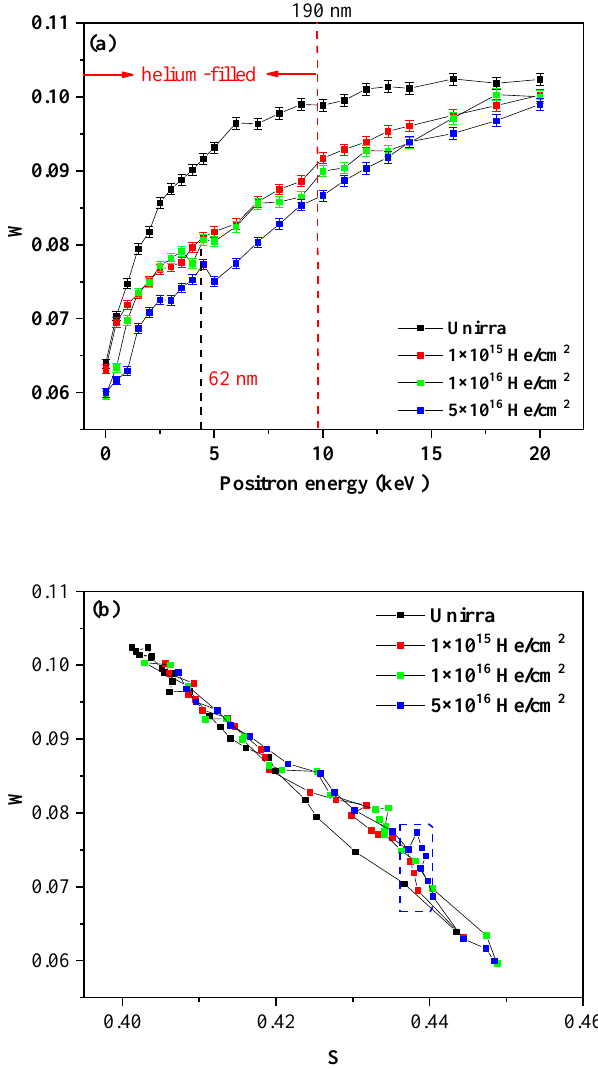
Figure 2. ( a ) W-E curves and ( b ) W-S curves for irradiated alloys and for unirradiated ones. In order to confirm the formation of helium bubbles in the specimens during irradiation, the alloy samples irradiated at different doses were observed by TEM. The surface morphology of the specimens before irradiation and after irradiation is shown in Figure 3. No defects were found in the alloys before irradiation. Only a few small radiation-induced defects appeared as black spots in the alloy irradiated with a dose of 1 × 10 15 He + /cm 2 , as shown in Figure 3b. As the dose increases, the black spot defects become more visible and show a three-dimensional grain shape, which were marked with blue arrows as shown in Figure 3c. These black spot defects may be small dislocation loops or defect clusters [32]. The size of these black spots in the specimen irradiated at 1 × 10 16 He + /cm 2 is significantly larger than that irradiated at low dose. The size of the black spot defect increases with the increase of the irradiation dose, which is consistent with the research results of Liu et al. They confirmed the growth of black spot defects (dislocation loops) with irradiation dose by in situ electron irradiation [33]. Small bubbles can be observed in the matrices of the Fe9Cr alloy irradiated at 5 × 10 16 He + /cm 2 (Figure 3d), while no bubbles are visible in the specimens irradiated at 1 × 10 15 He + /cm 2 and 1 × 10 16 He + /cm 2 . The observed helium bubbles confirm the above-mentioned positron measurement results for the speculation that helium bubbles formed in high-dose irradiated